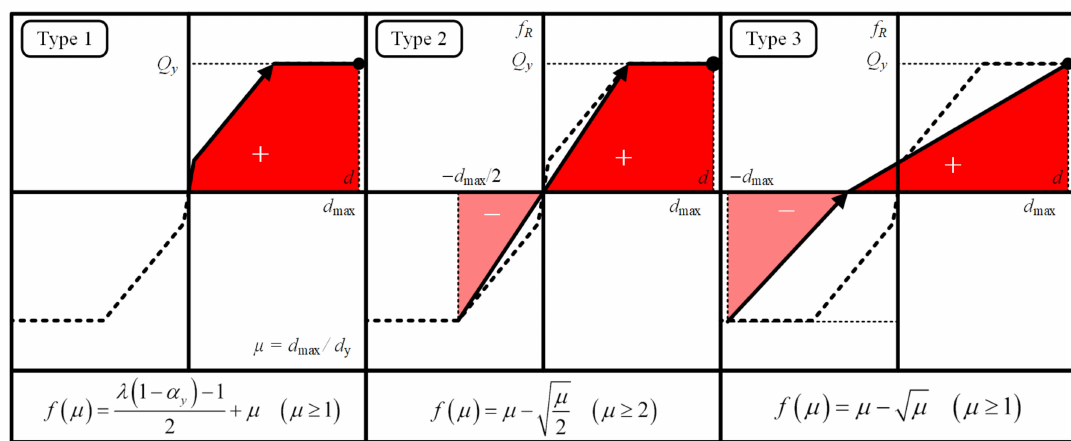
Figure 4. Modelling of increment in hysteretic dissipated energy in a half